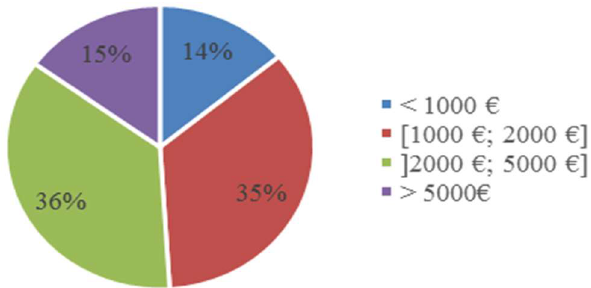
Figure 1. Percentage of residential consumers willing to invest, by investment value